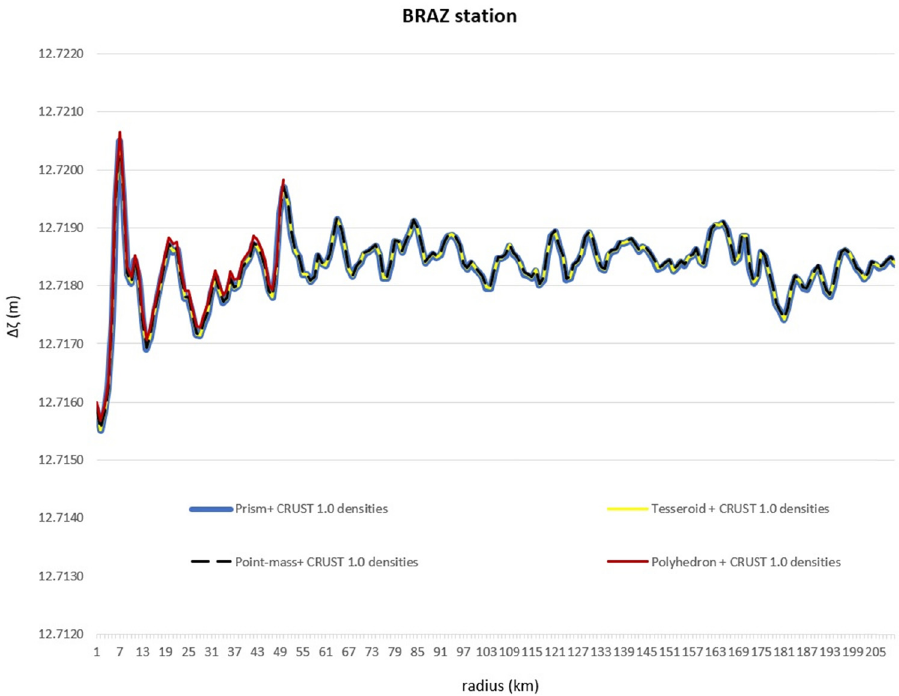
Figure 8: Di ff erences between RTM and BGS height anomalies ( Δζ ) on the integration radius intervals of each approach at BRAZ station using densities provided by CRUST 1.0.